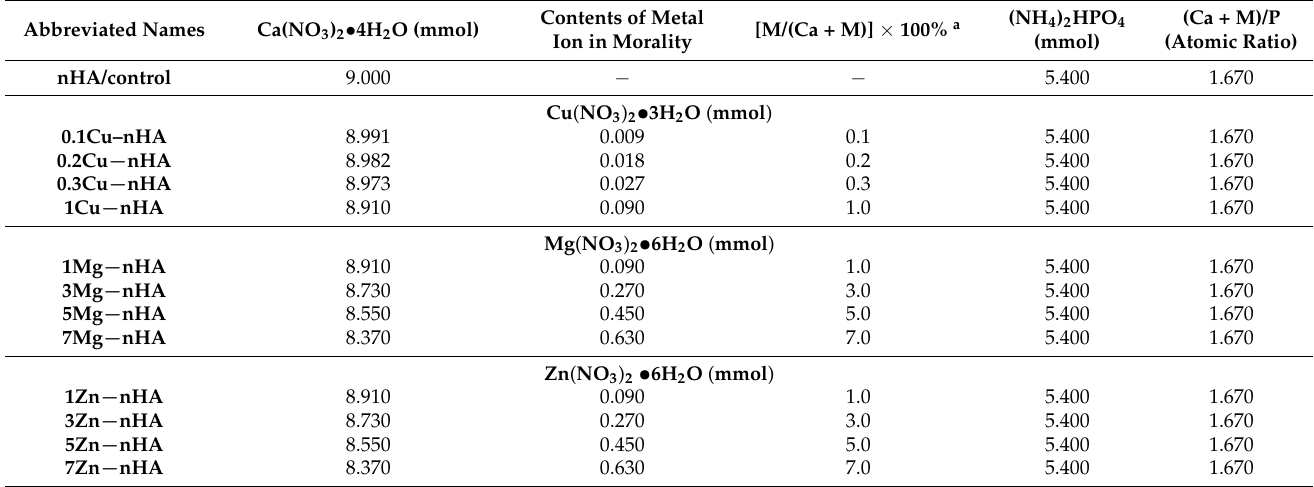
Table 3. Nomenclature of nanoapatite groups with metal ions at varying content during hydrothermal